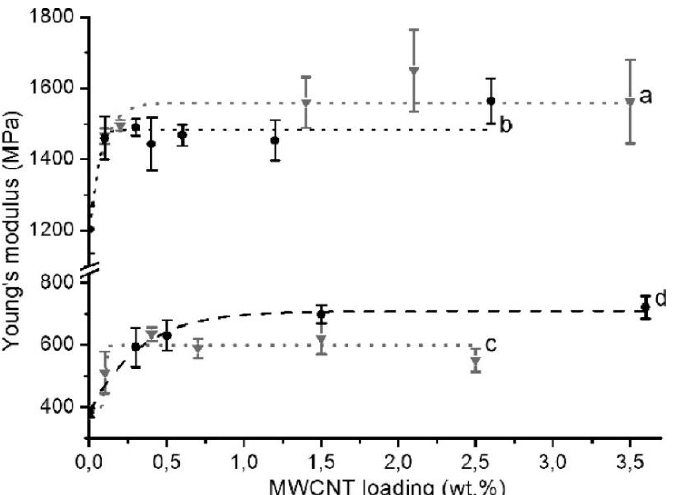
Figure 7. Elastic moduli as a function of unfunctionalized and functionalized MWCNT loading in polypropylene composites: ( a ) iPP/MWCNT, ( b ) iPP/C 11 –MWCNT, ( c ) sPP/MWCNT, and ( d ) sPP/C 11 –MWCNT [75]. Reprinted with permission from A.A. Koval’chuk, V.G. Shevchenko, A.N.